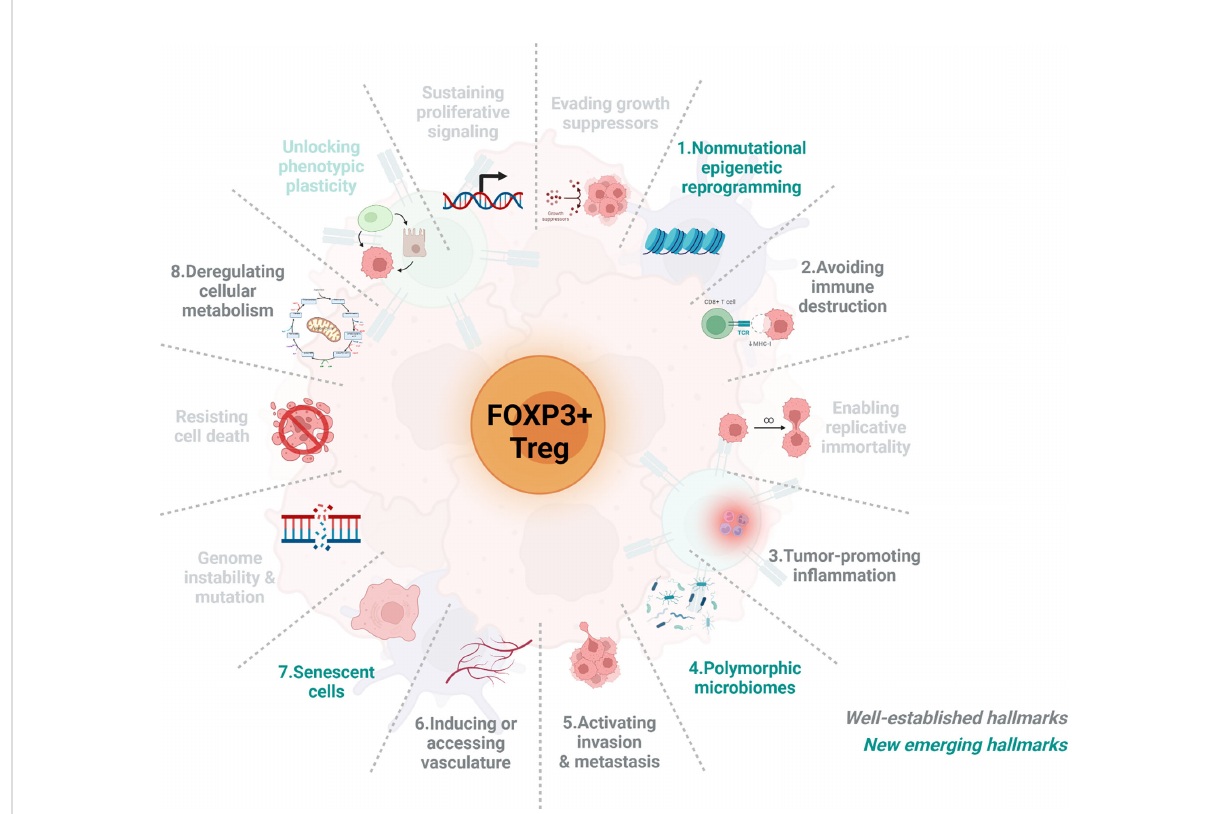
FIGURE 1 The schematic representation of the associations between FOXP3+ Treg cells and eight cancer hallmarks. Over the past decades, our understanding of cancer has evolved tremendously. Recently, Hanahan and Weinberg have categorized and summarized knowledge of cancers into 14 hallmarks, including 10 well-estlabished hallmarks (grey) and 4 new emerging hallmarks (green). Here we brie fl y introduce the connection between Treg cells dynamics and the feature of eight either well-established or new emerging cancer hallmarks including 1) nonmutational epigenetic reprogramming, 2) Avoiding immune destruction, 3) tumour-promoting in fl ammation, 4) polymorphic microbiomes, 5) activating invasion & metastasis, 6) inducing or accessing vasculature, 7) senescent cells, and 8) deregulating cellular metabolism. As very few papers have reported the association of Treg cells with the remaining hallmarks and thus will not be